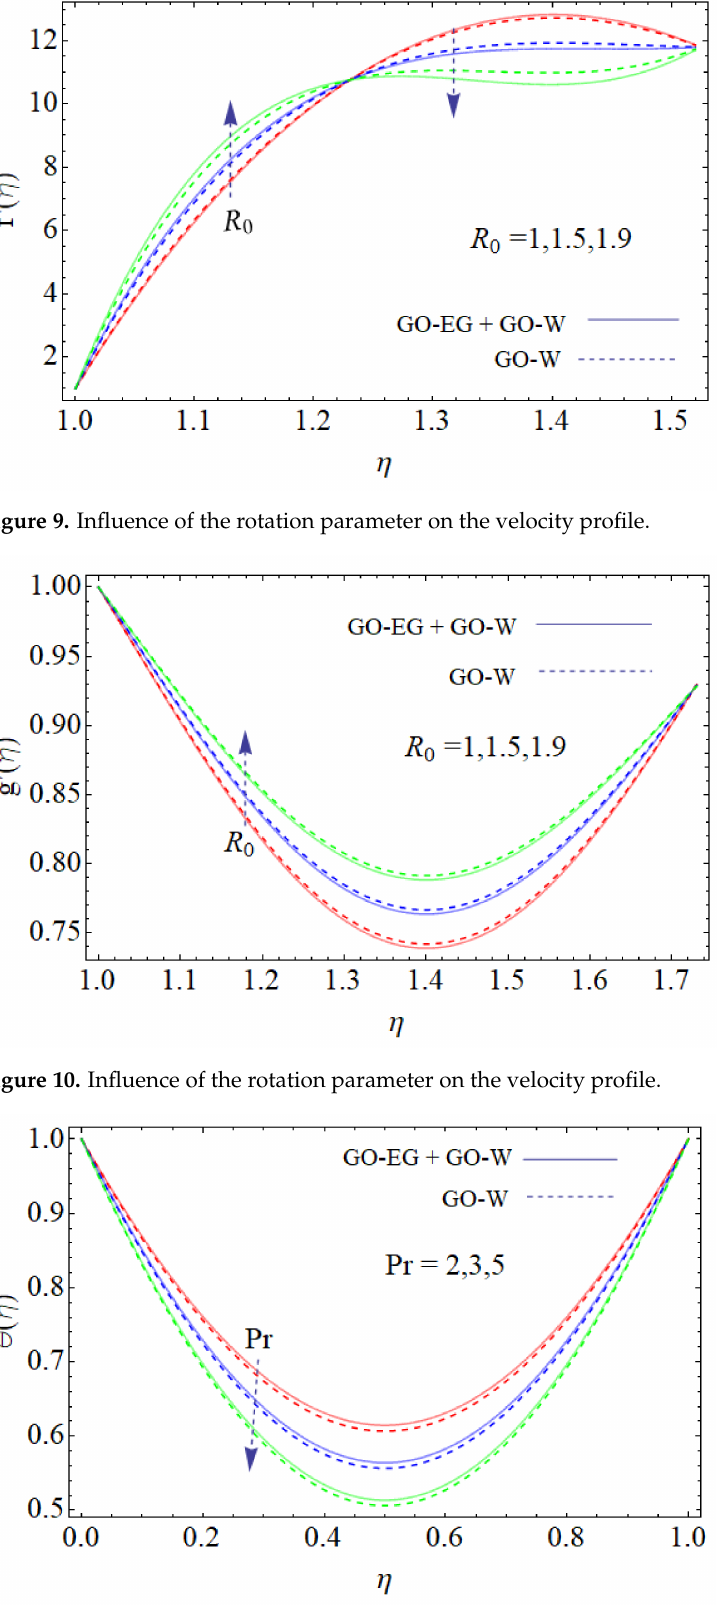
Figure 11. Influence of the Prandtl number on the temperature